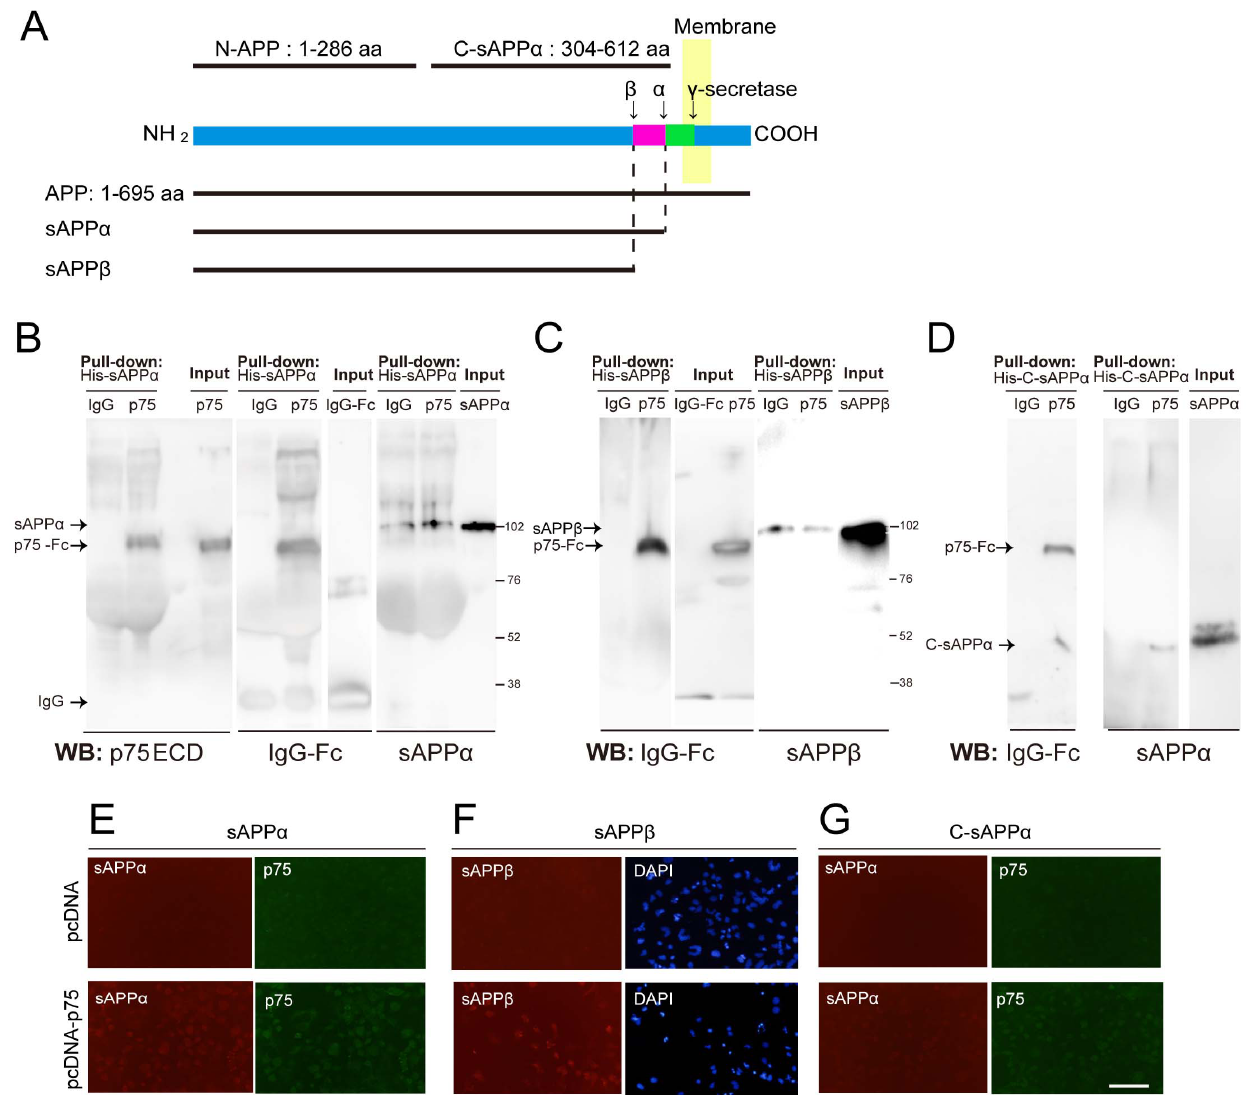
Figure 1. p75 NTR interacts with APP fragments. (A) Schematic representations of APP fragments. aa: amino acids. (B–D) Pull-down assays to assess the interaction of APP fragments with p75 NTR . His-tagged sAPP a (B), sAPP b (C), and C-sAPP a (D) protein were precipitated with Ni-agarose beads. p75 NTR ECD-Fc was co-precipitated with APP fragments. (E–G) Binding of recombinant APP fragments to p75 NTR on p75 NTR -pcDNA transfected COS-7 cells. The cells were transfected with p75 NTR inserted plasmid or control plasmid, and the binding of sAPP a (E), sAPP b (F), or C-sAPP a (G) on the cells was assessed by immunocytochemistry. Scale bar: 100 m m.